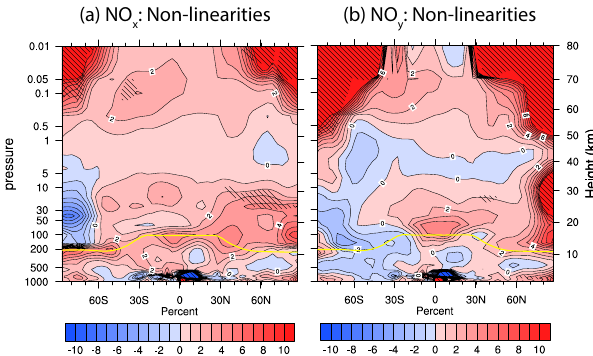
Fig. 6. Differences between the DM-ALL vs. DM-CTRL1780 field and between the (DM-TD+DM-BU+DM-VOLC+DM-EPP) vs. DM-CTRL1780 field. Positive values show a positive anomaly of the stacked differences over the DM-ALL difference field. Hatched areas are significantly different on a Student’s t test with α = 10%. The yellow line illustrates the height of the WMO